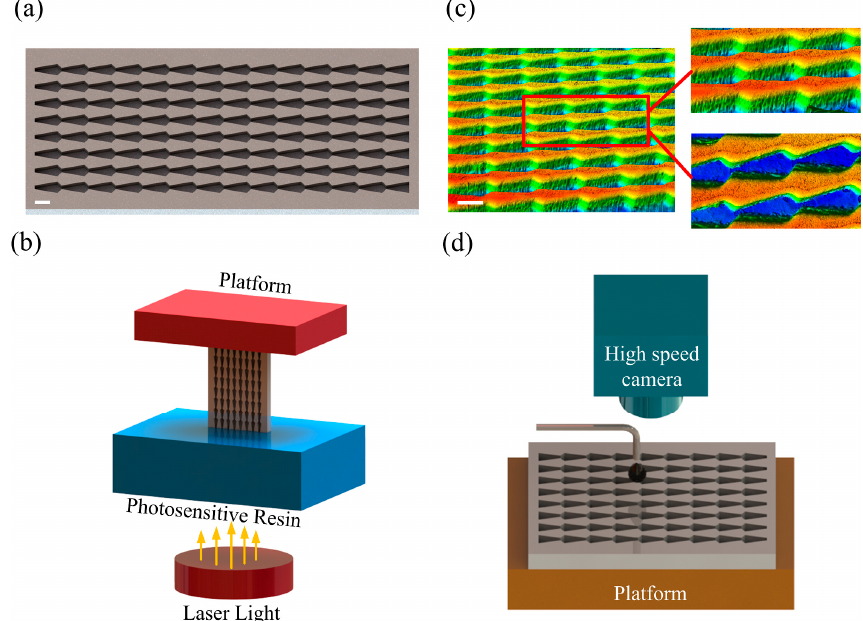
Figure 3. ( a ) Three-dimensional diagram of the arrowhead array (scale bar = 1 mm). ( b ) Conceptual diagram of photocuring 3D printing. ( c ) Microstructural image under a microscope (scale bar = 1 mm). ( d ) Schematic of the high-speed camera.